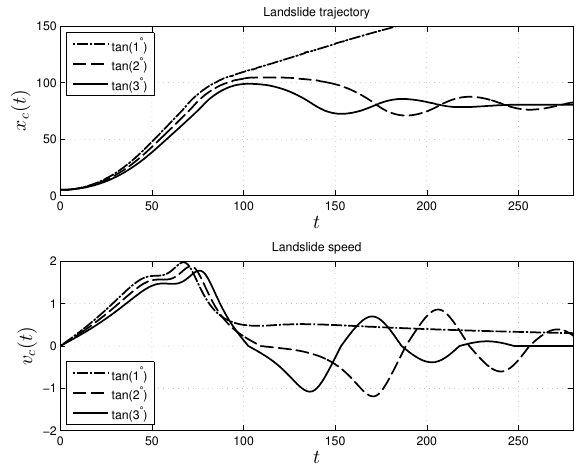
Figure 2. Position and velocity of the barycenter of the landslide as functions of Fig. 2. Position and velocity of the barycenter of the landslide as dimensional time for three different values of the friction coefficient functions of dimensional time for three different values of the fric- c f . tion coefficient c f is needed to dissipate the landslide kinetic energy independently of its direction of motion. Thus the force F r takes the form